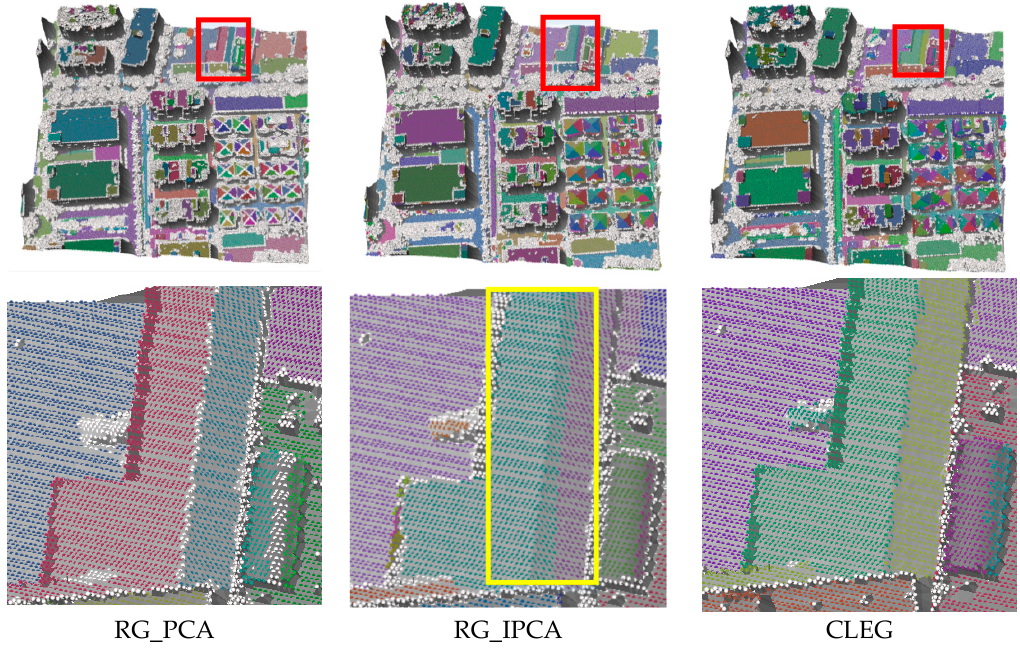
Figure 14. Segmentation results in the Guangzhou area using dataset (c).